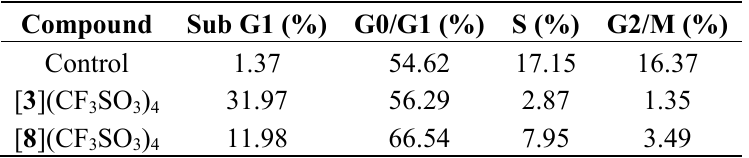
Table 2. Distribution of A-549 cells in various phases of the cell cycle in the presence of